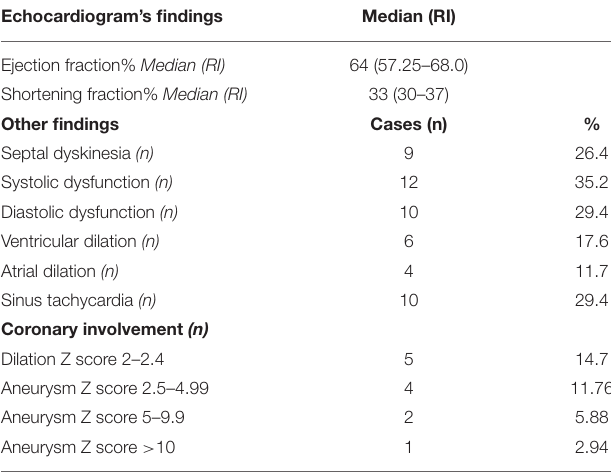
TABLE 2 | Cardiovascular findings in children with